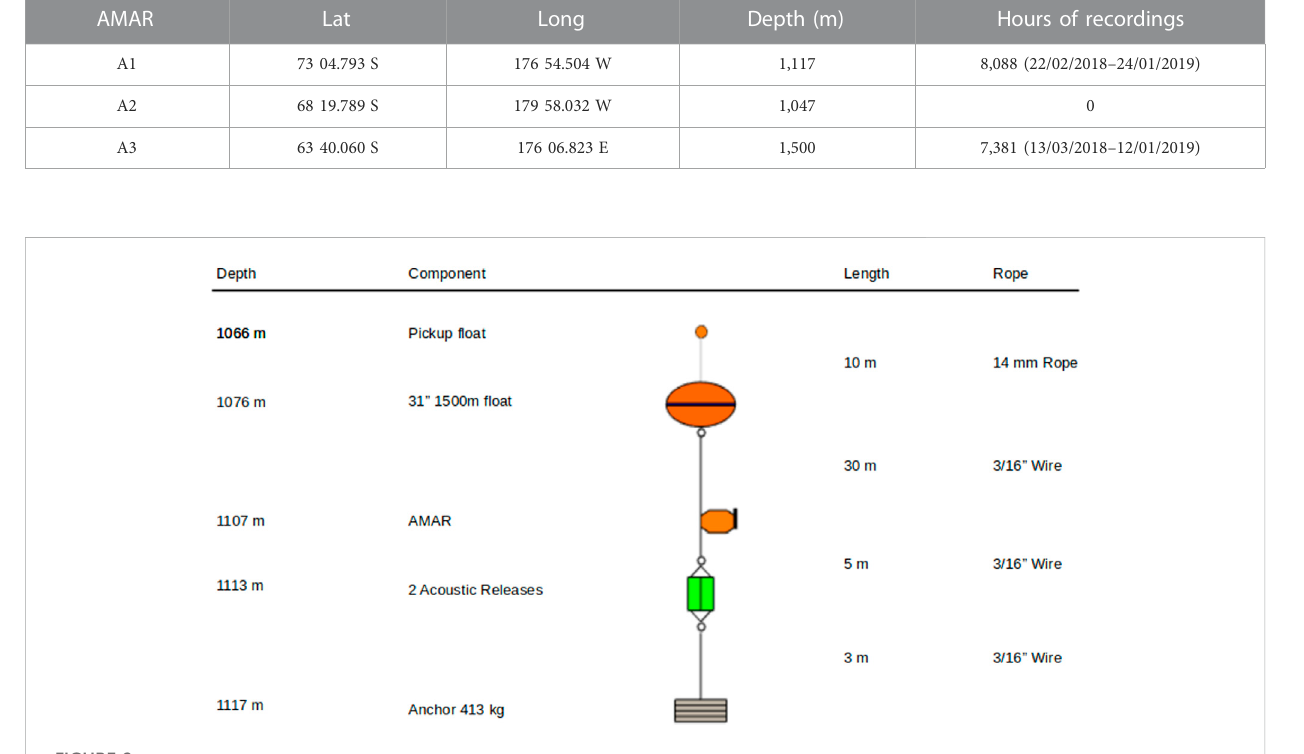
FIGURE 2 Mooring design (all stations) and depths (station